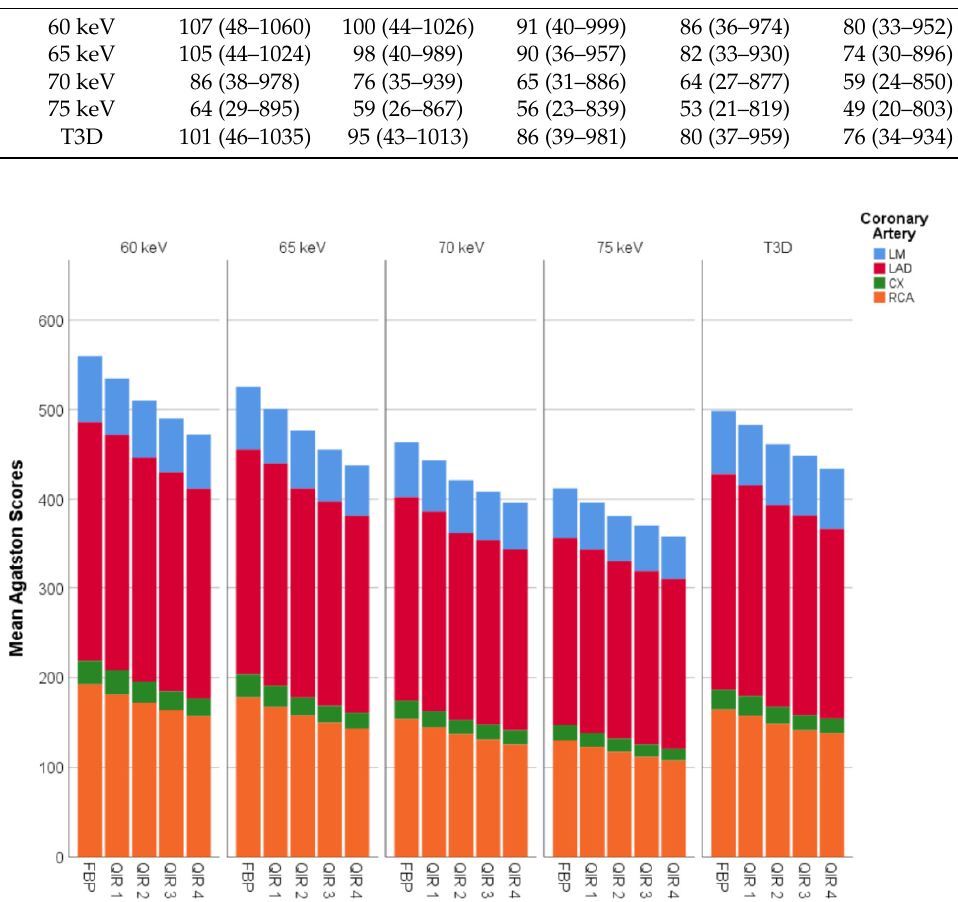
Figure 4. Data of 20 patients show that virtual monoenergetic image reconstructions at increasing keV ( p < 0.001 for each eV increase) and increasing strength levels of Quantum Iterative Reconstruction (QIR; p < 0.001 for each increase in strength level) led to decreasing calcium scores. There was no difference of calcium scores between 65 keV monoenergetic reconstructions and T3D (equivalent to polychromatic 120 kV) (all, p > 0.05).